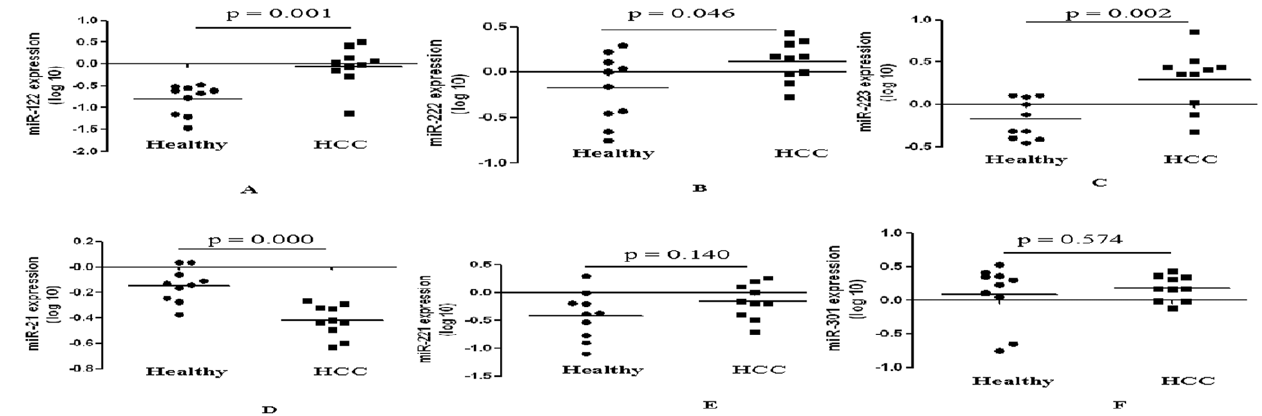
Figure 1. Expression levels of miRNAs in serum of HCC patients and healthy subjects. Levels of miR-122 (A), miR-222 (B), miR-223 (C), miR- 21 (D), miR-221 (E), and miR-301 (F) were measured in serum of HCC patients (n=10) and healthy subjects (n=10) by RT-qPCR. Using miR-16 as normalization control, 3 significantly up-regulated miRNAs (miR-122, miR-222 and miR-223) and 1 significantly down-regulated miRNA (miR-21) in serum in HCC patients were identified, while expression levels of miR-221 and miR-301 in serum were non-significantly higher in HCC patients than in healthy subjects.